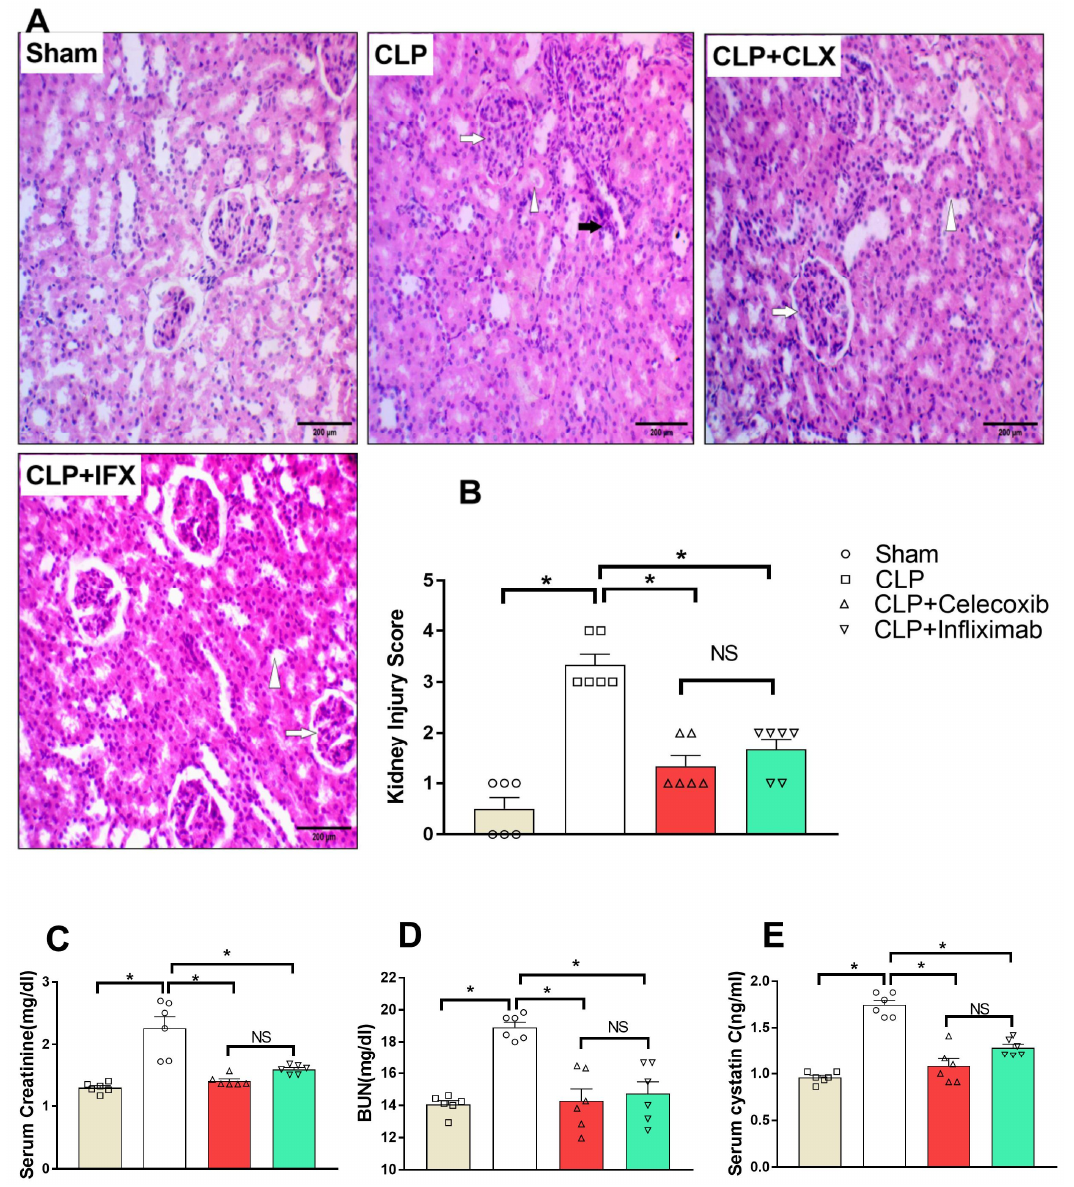
Figure 5. Effect of CLP induction and treatment with CLX and IFX against sepsis-induced AKI. ( A ). Photomicrographs showing the effect of CLX and IFX administration on sepsis-induced kidney injury (H&E stain, 200 × ). The sham group showed normal renal glomeruli and tubules. The CLP group showed injuries of the glomerulus (white arrow) in the form of congested and fibrosed glomerulus capillaries, mesangial cell proliferation, and narrow to obliterated bowman’s spaces. Tubular injury (arrowhead) came in the form of tubular edema, intratubular casts, and focal areas of tubular damage. In the interstitial tissue (black arrow), edema and chronic inflammatory cellular infiltrates were in the form of lymphocytic aggregates. The CLP/CLX and CLP/IFX groups showed marked protection against the effect of sepsis, which was apparent in the form of the normal structure of the glomerulus, without congestion or mesangial cell proliferation (arrow). Normal tubular structures (arrowhead) were without edema, tubular casts, or destruction. Interstitial tissue was thin and free of congestion or inflammation. ( B ). Analysis of kidney injury score. ( C ). Effect of different groups on serum CR. ( D ). Effect of different groups on serum BUN. ( E ). Effect of different groups on serum cystatin ( C ). Each value represents the mean ± SEM; n = 6 for all groups. * denotes significant difference at p < 0.05.